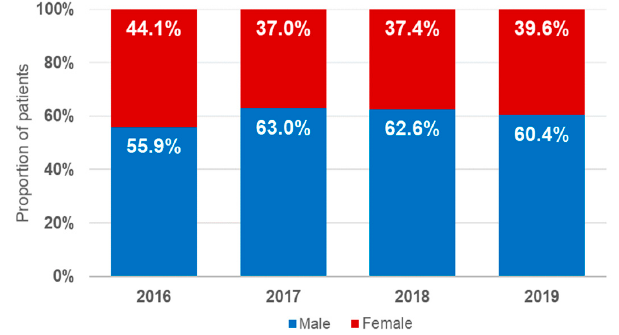
Figure 1. Sex distribution of the analyzed VREBI samples.